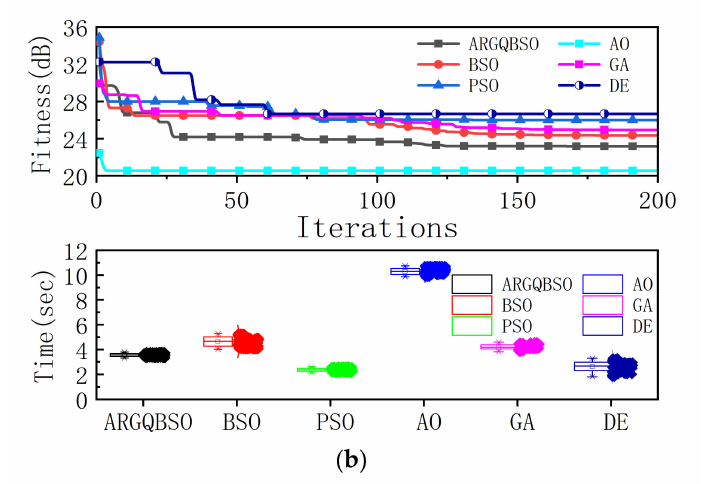
Figure 8. ( a ) Box plot of the three algorithms for EII, EIRP, EIS, and noise floor P n . ( b ) Iterative curve and operation time of the four